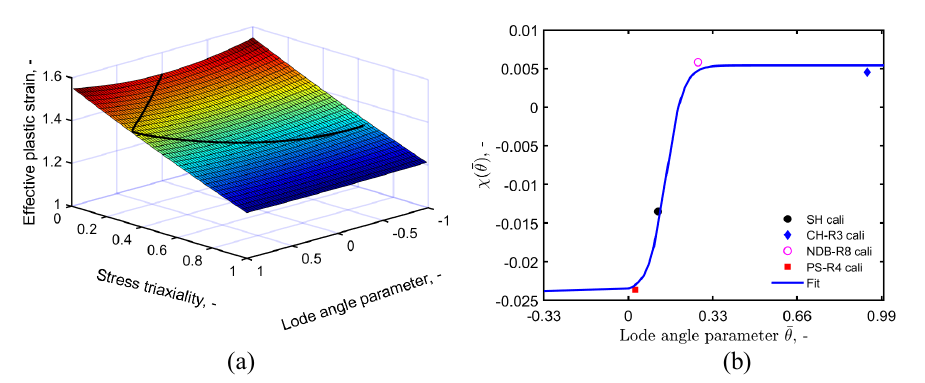
Fig. 10. (a) Calibrated fracture initiation locus at 0.005 mm/s (QS), (b) Coefficient (cid:2031)((cid:2016)̅) .